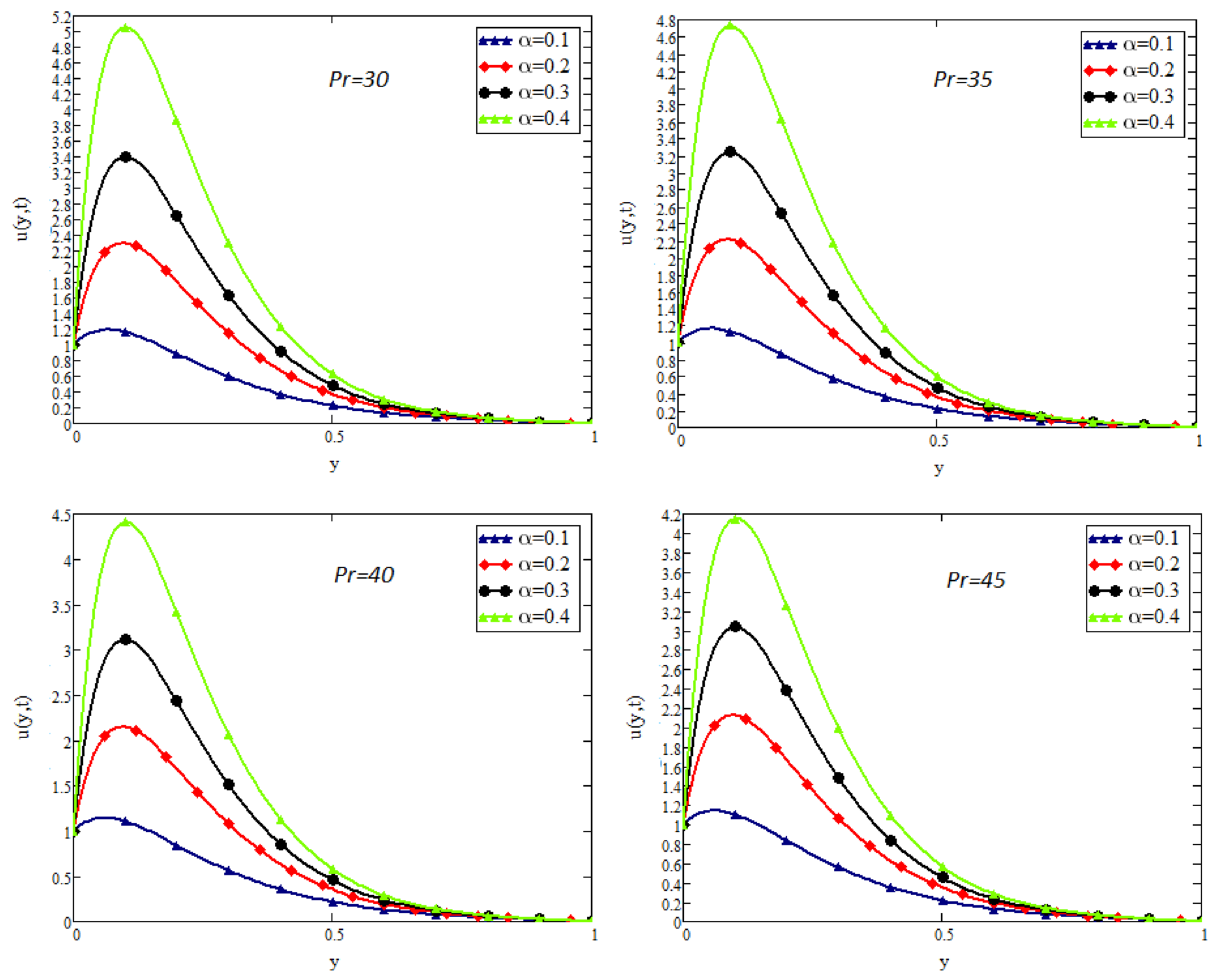
Figure 5. Impact of Pr on velocity distribution when t = 1 , Gr = 1.5 , Gm = 1.5 , Sc = 20 , β = 2 , and (cid:31) = 1